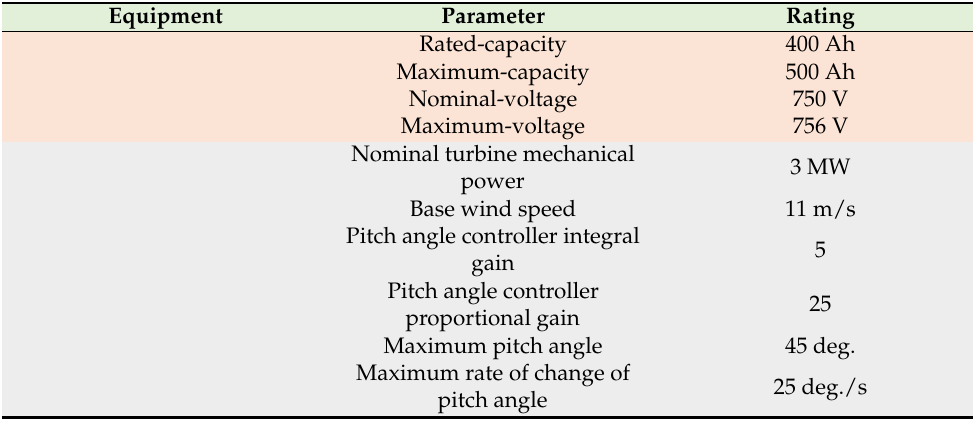
Figure 3. Wind System with controller. The reference current dcref i